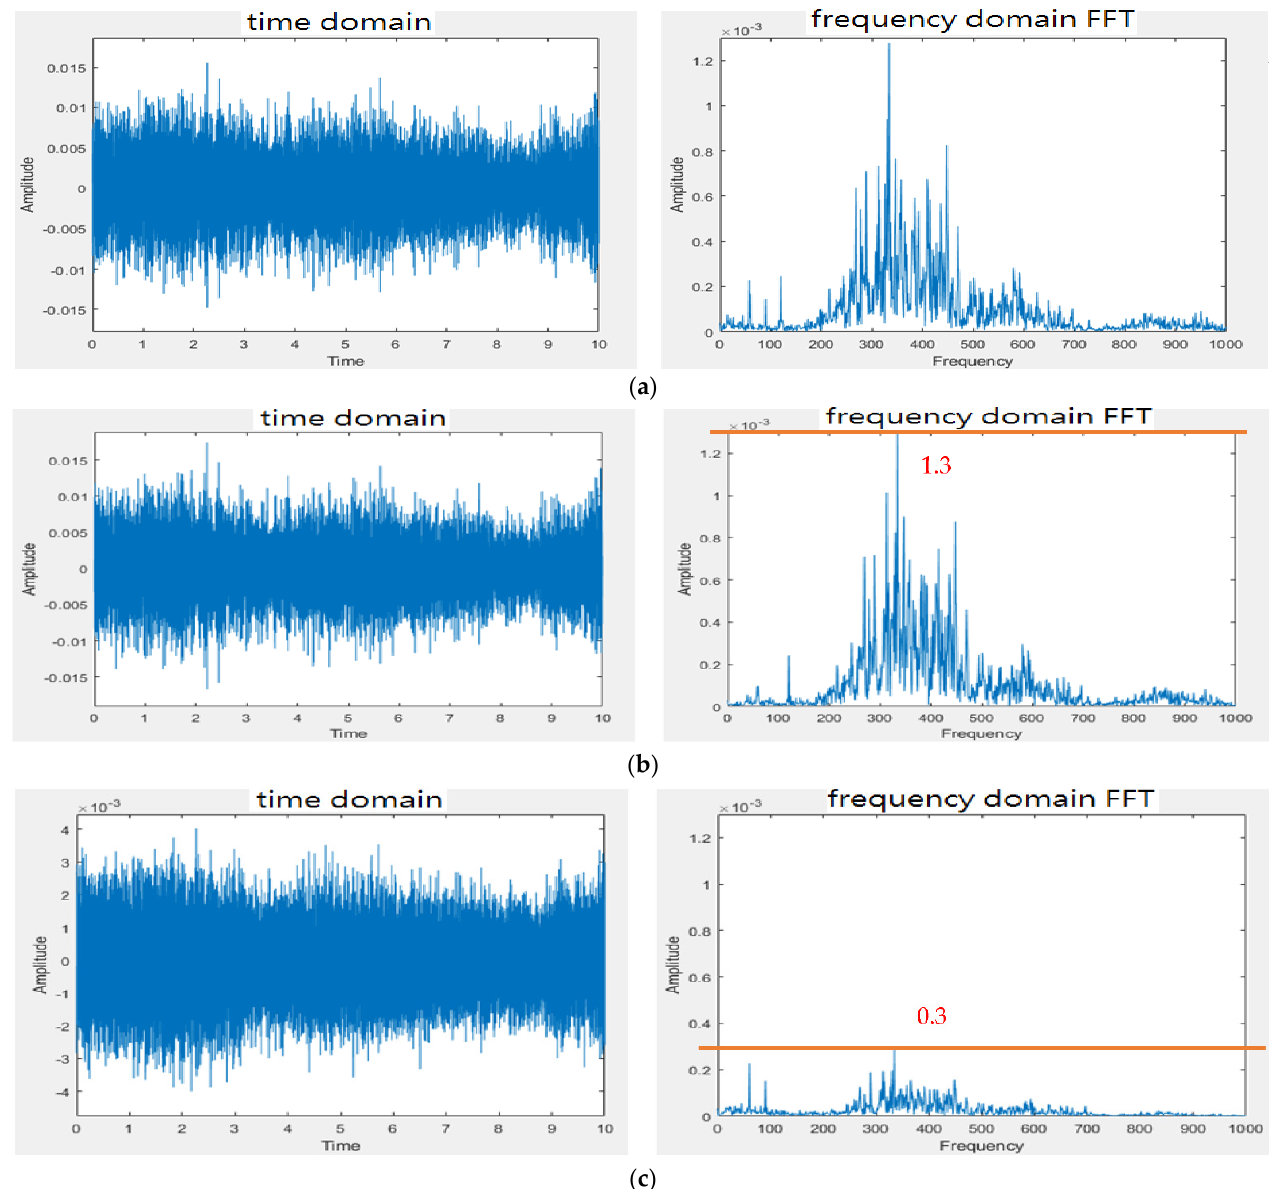
Figure 12. Noise reduction effect for ward construction noise. ( a ) Signal waveform and FFT spectrum measured by mic 1. ( b ) Signal waveform and FFT spectrum measured by mic 2. ( c ) Signal waveform and FFT spectrum after noise reduction frequency domain FFT Time domain